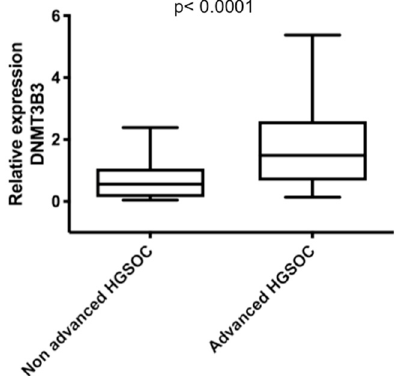
Figure 4. DNMT3B3 overexpression validated in advanced stages of high-grade serous ovarian carcinoma (HGSOC). DNMT3B3 isoform overexpression in two arrays of cDNA rapid cDNA panels: II and III, of ovarian carcinoma (TissueScan Ovarian Cancer cDNA arrays II and III) (OriGene Technologies, Rockville MD) (cat. no. HORT102, and 103) (n = 82). Non-advanced HGSOC (n = 23: mucinous, low-grade serous ovarian carcinoma, endometrioid, carcinoma clear cells, and stages I–II of HGSOC) versus advanced HGSOC (n = 59: stages III–IV of HGSOC). Assays were normalized with GAPDH expression in each case and ten controls of the normal ovary. Mann–Whitney U test was used.